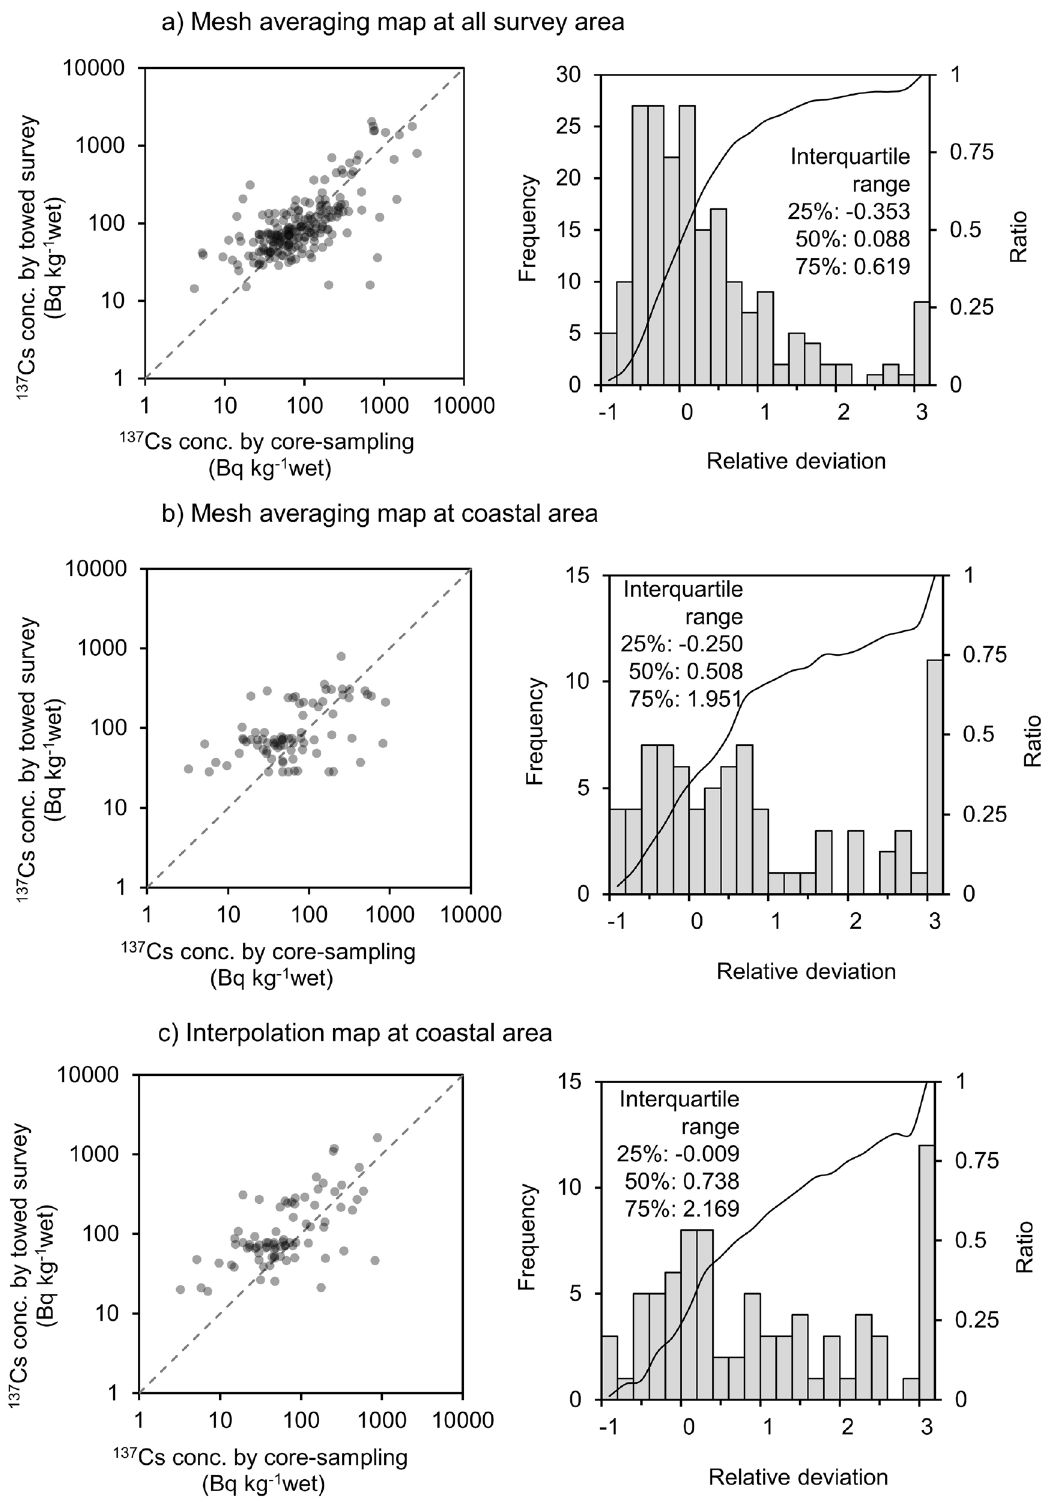
Figure 3. The comparison between 137 Cs concentration of sediment core sample with towed radiation survey for validation of the towed radiation survey. ( a ) all survey area of all campaign, ( b ) limitation of the coastal area of the mesh averaging map and ( c ) limitation of the coastal area of the interpolation